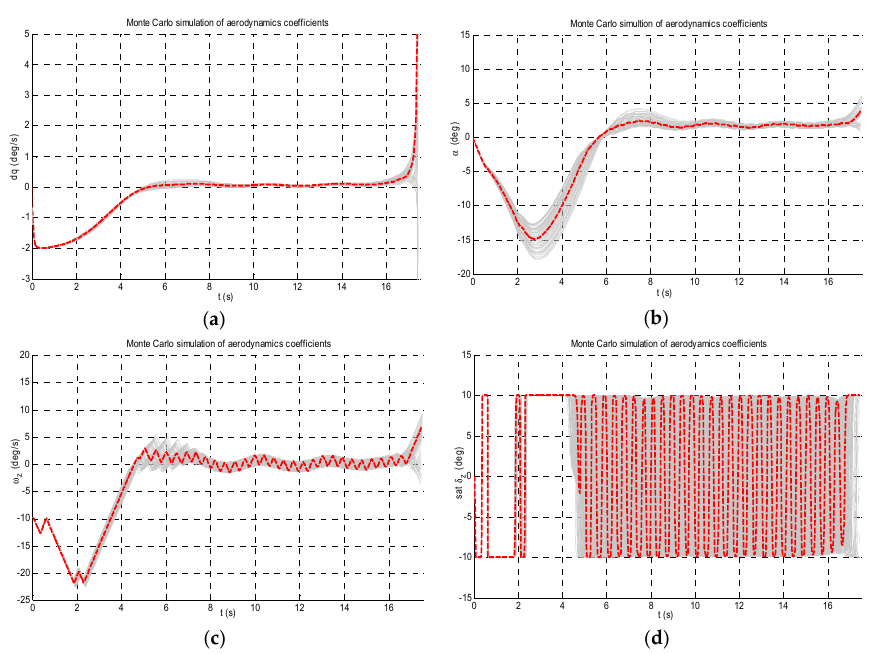
. q , ( b ) curves of α ,